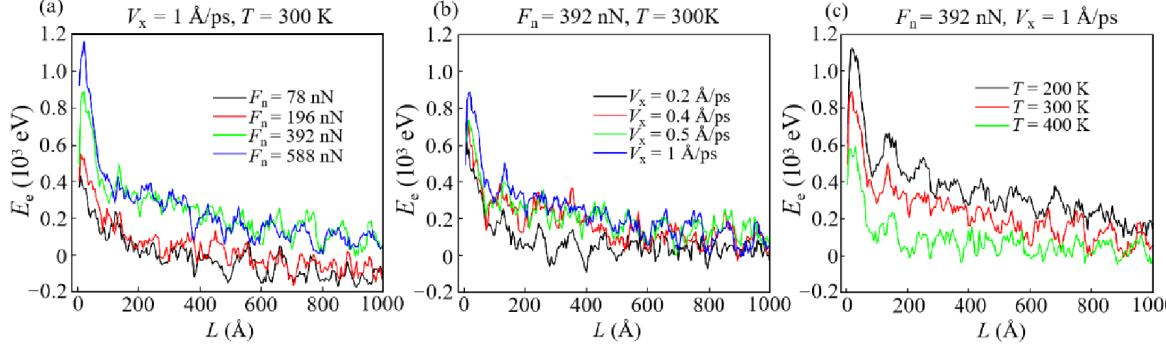
Figure 9. The evolution of elastic potential energy E e under different conditions : ( a ) V x = 1 Å /ps, T = 300 K; ( b ) F n = 392 nN, T = 300 K; ( c ) F n = 392 nN, V x = 1 Å